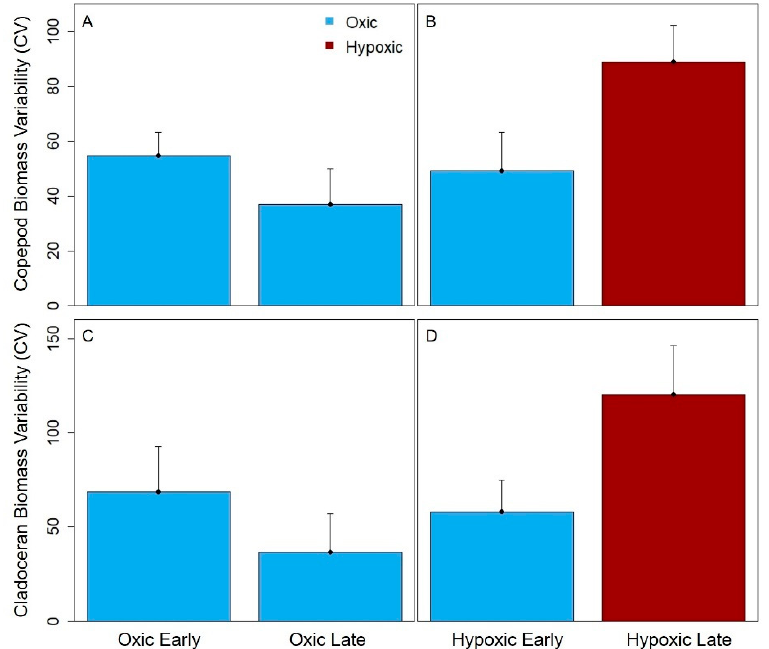
Figure 5. Mean (error bar is 1 standard deviation) copepod ( A , B ) and cladoceran ( C , D ) biomass variability between the early and late stratified periods for the seasonally oxic reservoirs (left column) and seasonally hypoxic reservoirs (right column). Note the different scales in copepod and cladoceran biomass variability. Table 5. Wilcoxon signed rank test statistics of the difference in crustacean zooplankton, cladoceran and copepod biomass variability and the compositional variability of crustacean zooplankton biomass between the early (when all reservoirs were oxic) and late stratified periods across years in oxic and hypoxic reservoirs. Only the compositional variability of total crustacean zooplankton (not individual copepod or cladoceran group taxa) was calculated because there were only two copepod taxa present in the reservoirs. A positive mean difference indicates that the value increased from the early to late stratified period. Bold P -values highlight statistically significant ( P < 0.10) two-tailed P- values.